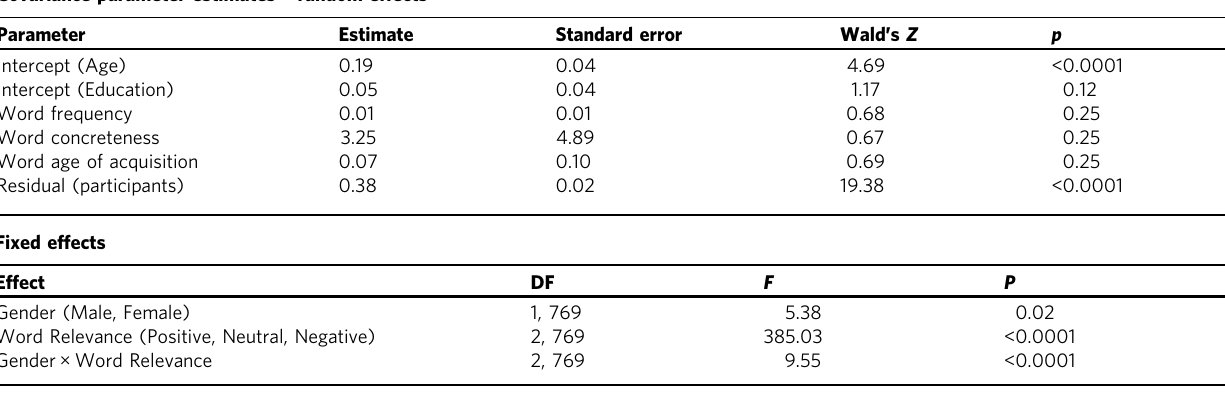
Table 3 Results of repeated measures mixed linear model analysis of word rating data ( n = 94 participants). Covariance parameter estimates – random